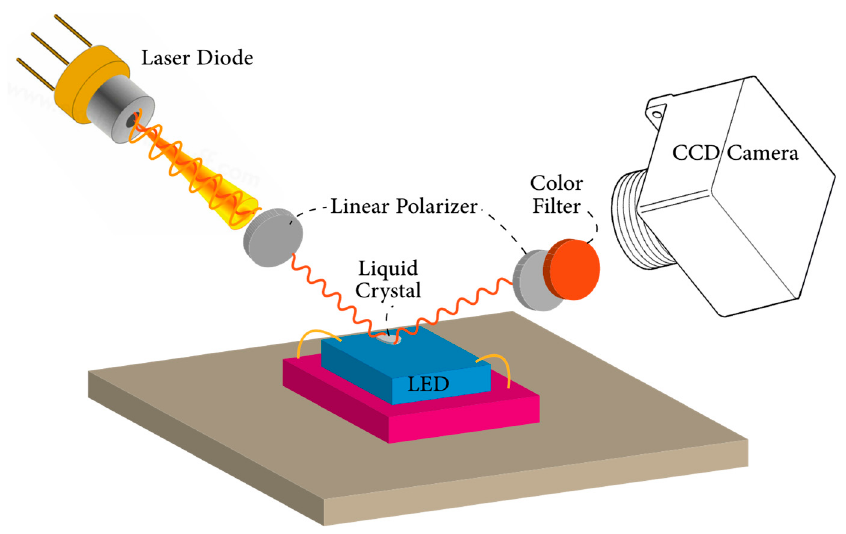
Figure 11. A schematic of the experimental arrangement of the liquid crystal thermography technique. The test setup is typically composed of a polarized laser beam, a charge-coupled camera with a color filter, and liquid crystal coated over the LED surface.